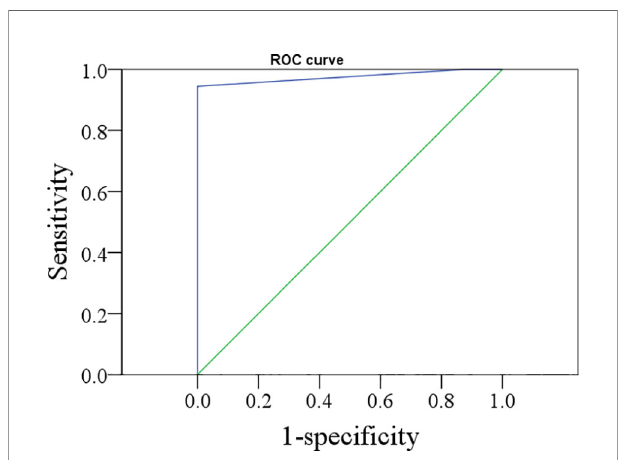
FIGURE 1 | The ROC curve of thyroglobulin in the washout of the needle for indicating lymph node metastasis.